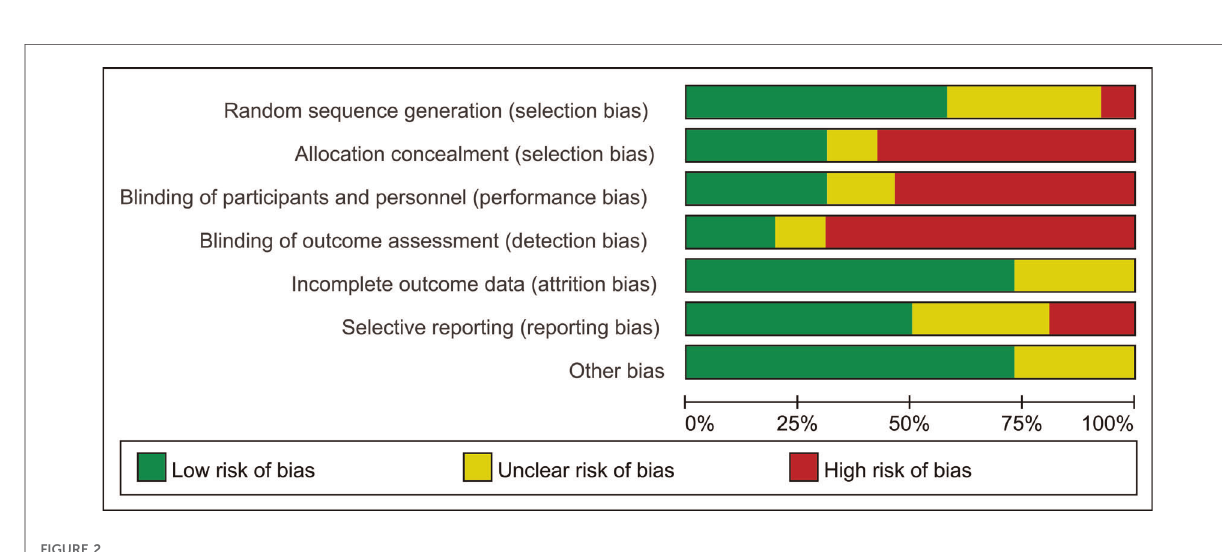
FIGURE 2 Results of quality assessment using the Cochrane risk